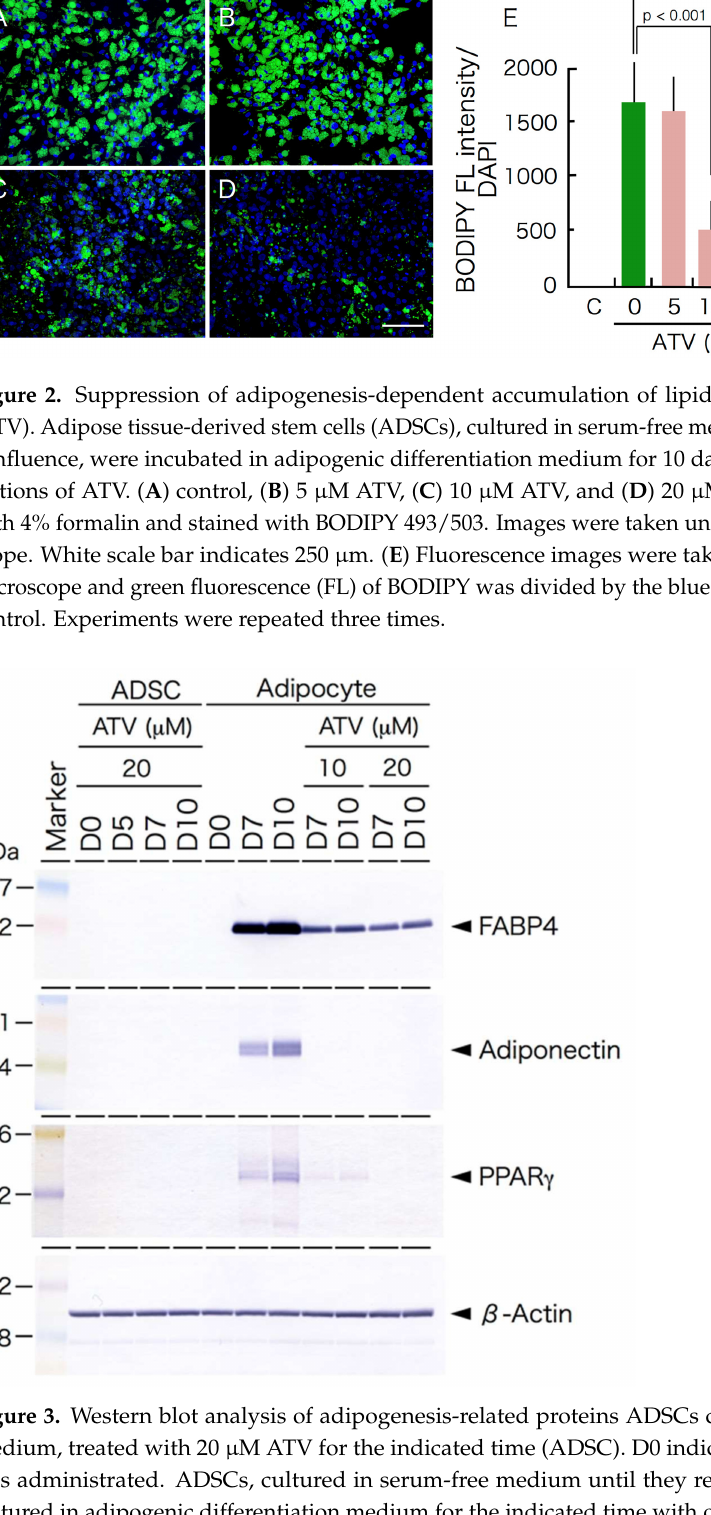
Figure 1. Suppression of adipogenic differentiation of ADSCs by ATV. ADSCs, cultured in serum free medium until they reached confluence, were incubated in adipogenic differentiation medium for 10 days with varying concentrations of ATV. A; control, B; 5 μ M ATV, C; 10 μ M ATV, D; 20 μ M ATV. Images were taken under a phase-contrast microscope. White scale bar indicates 250 μ m.